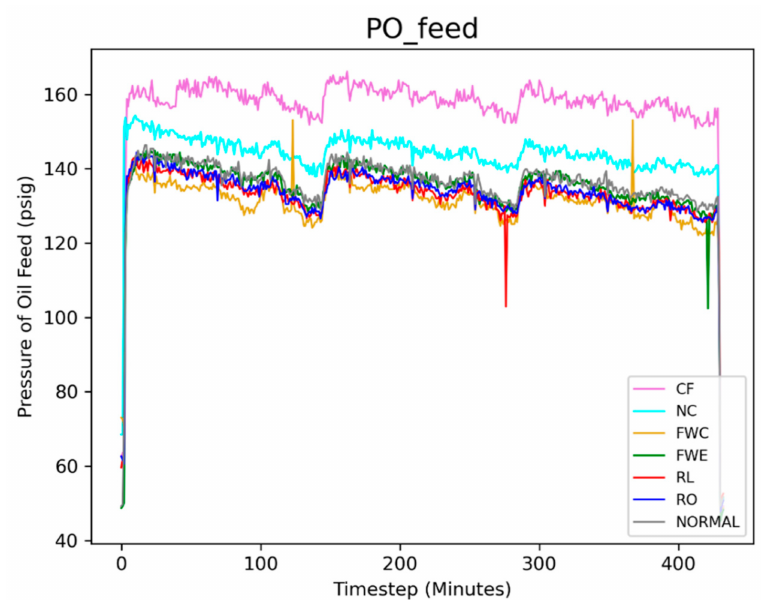
Figure 2. Trends of the PO_feed